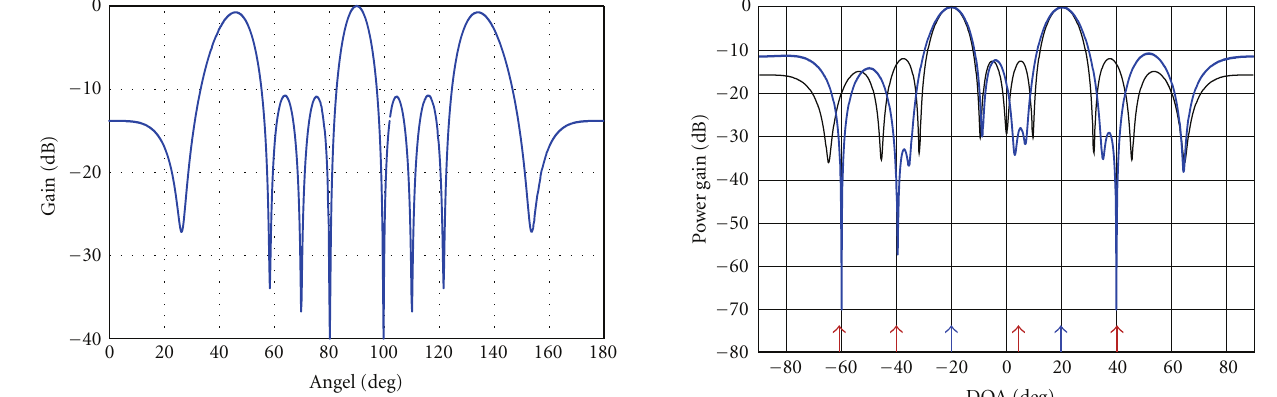
Figure 7: Adapted beam pattern of an antenna array with two desired signals ( − 20 ◦ , 20 ◦ ) and four interfering sources ( − 60 ◦ , − 40 ◦ , 5 ◦ , 40 ◦ ). Both the interfering signals at − 40 ◦ and 5 ◦ are correlated to signal at − 20 ◦ with α = (0.1, − 0.23) and ( − 0.15, 0.08), respectively. c = [1 1 0 0];